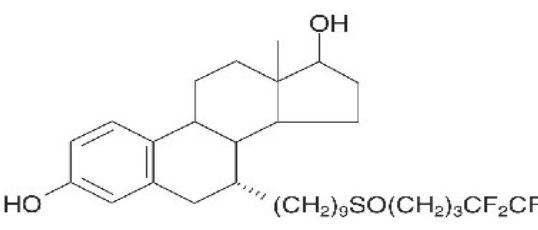
Figure 5. Chemical structure of